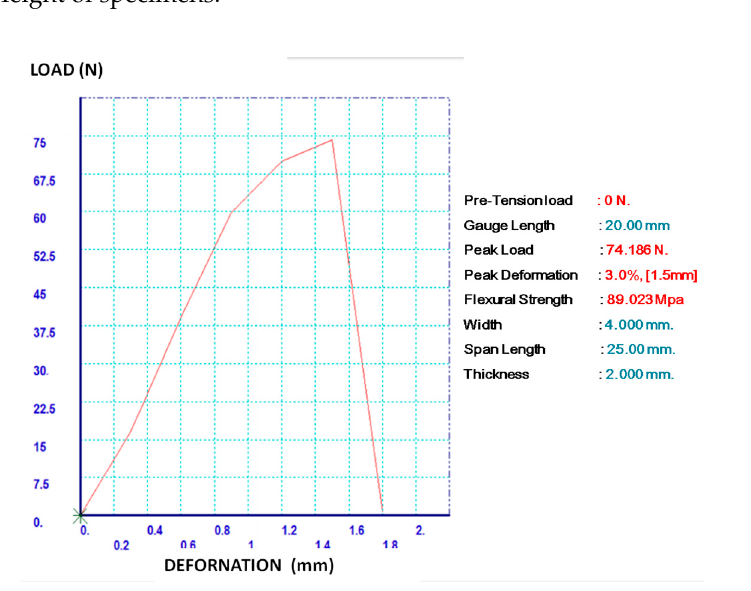
Figure 3. Load deformation graph while conducting the